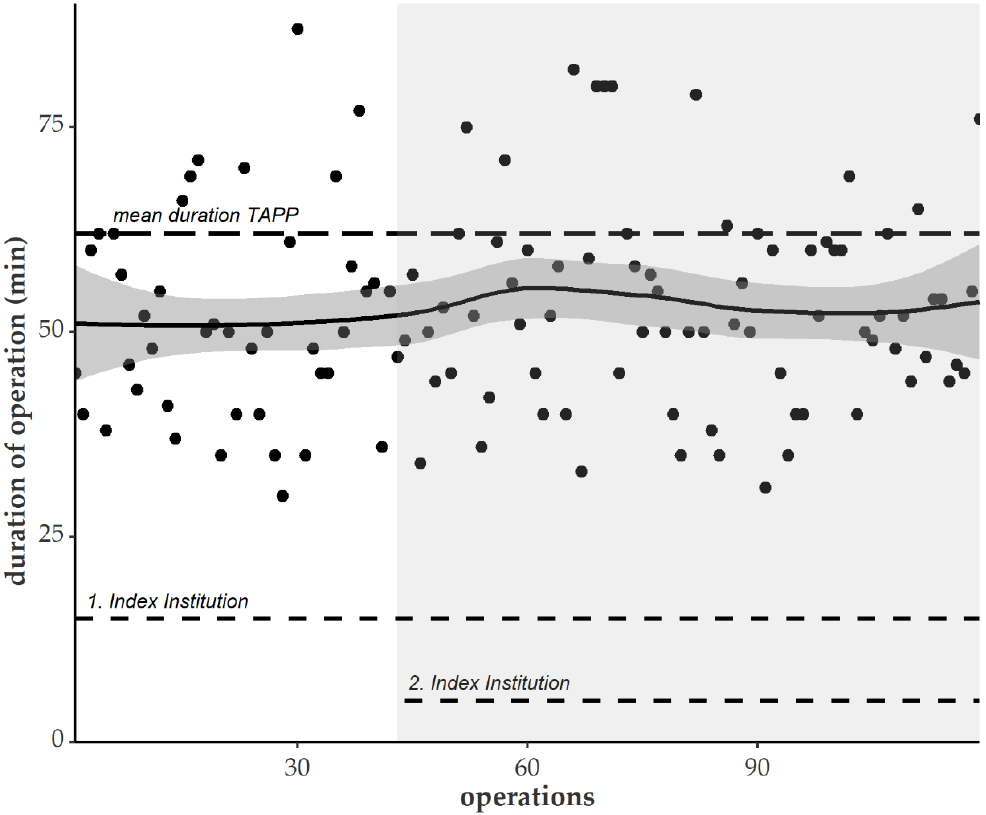
Figure 2. Correlation of operation time and number of procedures performed. The white area indicates single center results, and the area shaded light gray includes results from both hospitals. Dashed lines show mean duration of transabdominal preperitoneal patch plasty (TAPP) operation.